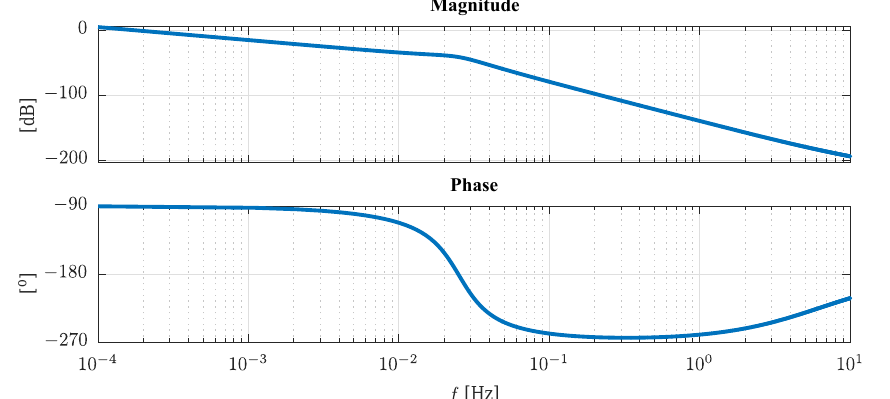
Figure 12. Bode analysis of the designed controller K .